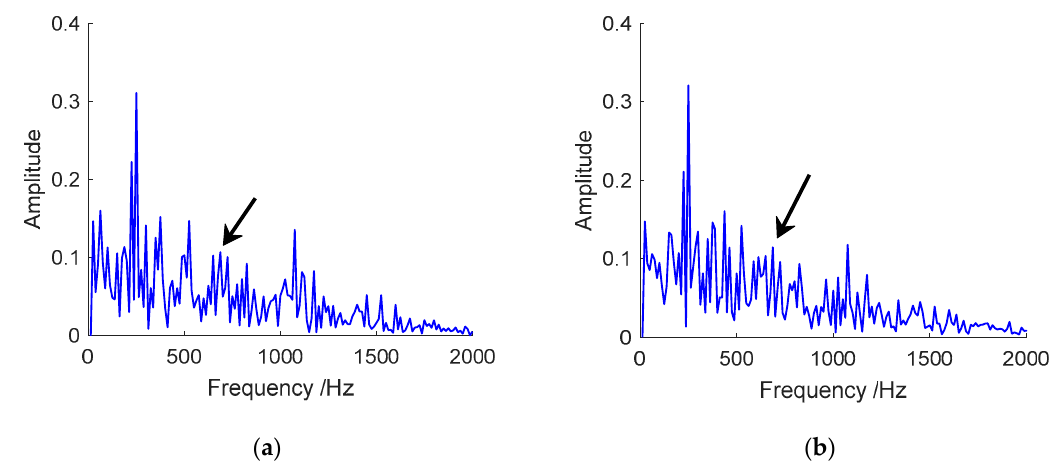
Figure 25. The envelope spectra based on the reconstructed TFD 1 and 3: ( a ) Envelope spectrum based on the reconstructed TFD 1; ( b ) envelope spectrum based on the reconstructed TFD 3.